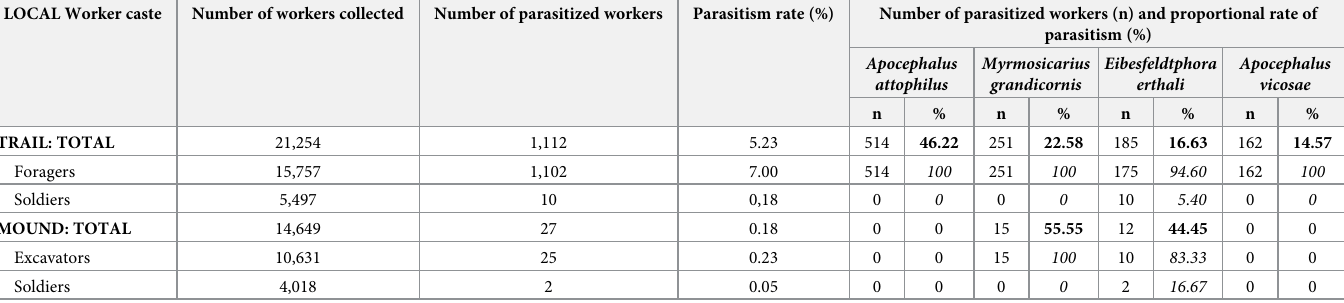
Table 1. Total and proportional parasitism rates of four species of phorid flies attacking Atta laevigata workers (foragers, excavators and soldiers) collected on trails or from soil mounds. LOCAL Worker caste Number of workers collected Number of parasitized workers